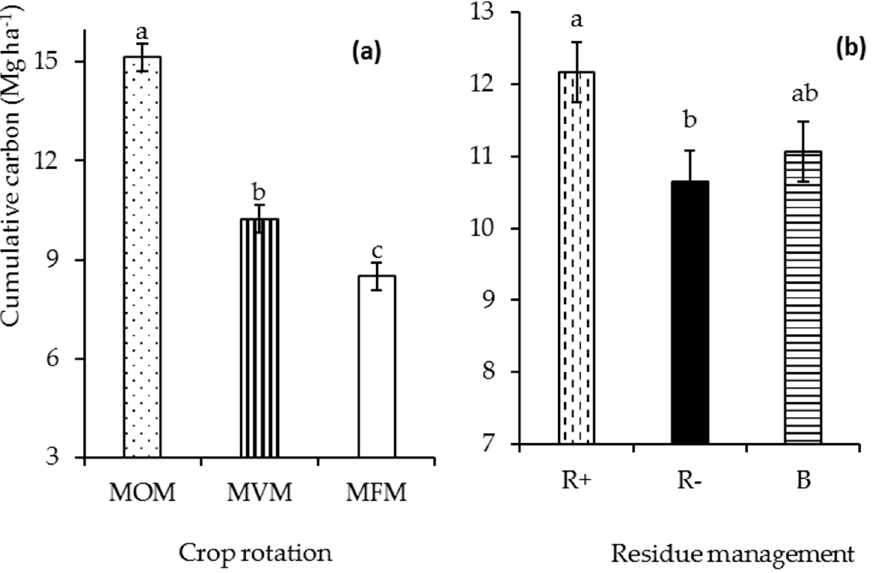
Figure 2. Effects of crop rotation ( a ) and crop residue management ( b ) on cumulative carbon input (Mg ha − 1 ) for six seasons (2015–2017). Different lowercase letters indicate significant differences at p < 0.001.